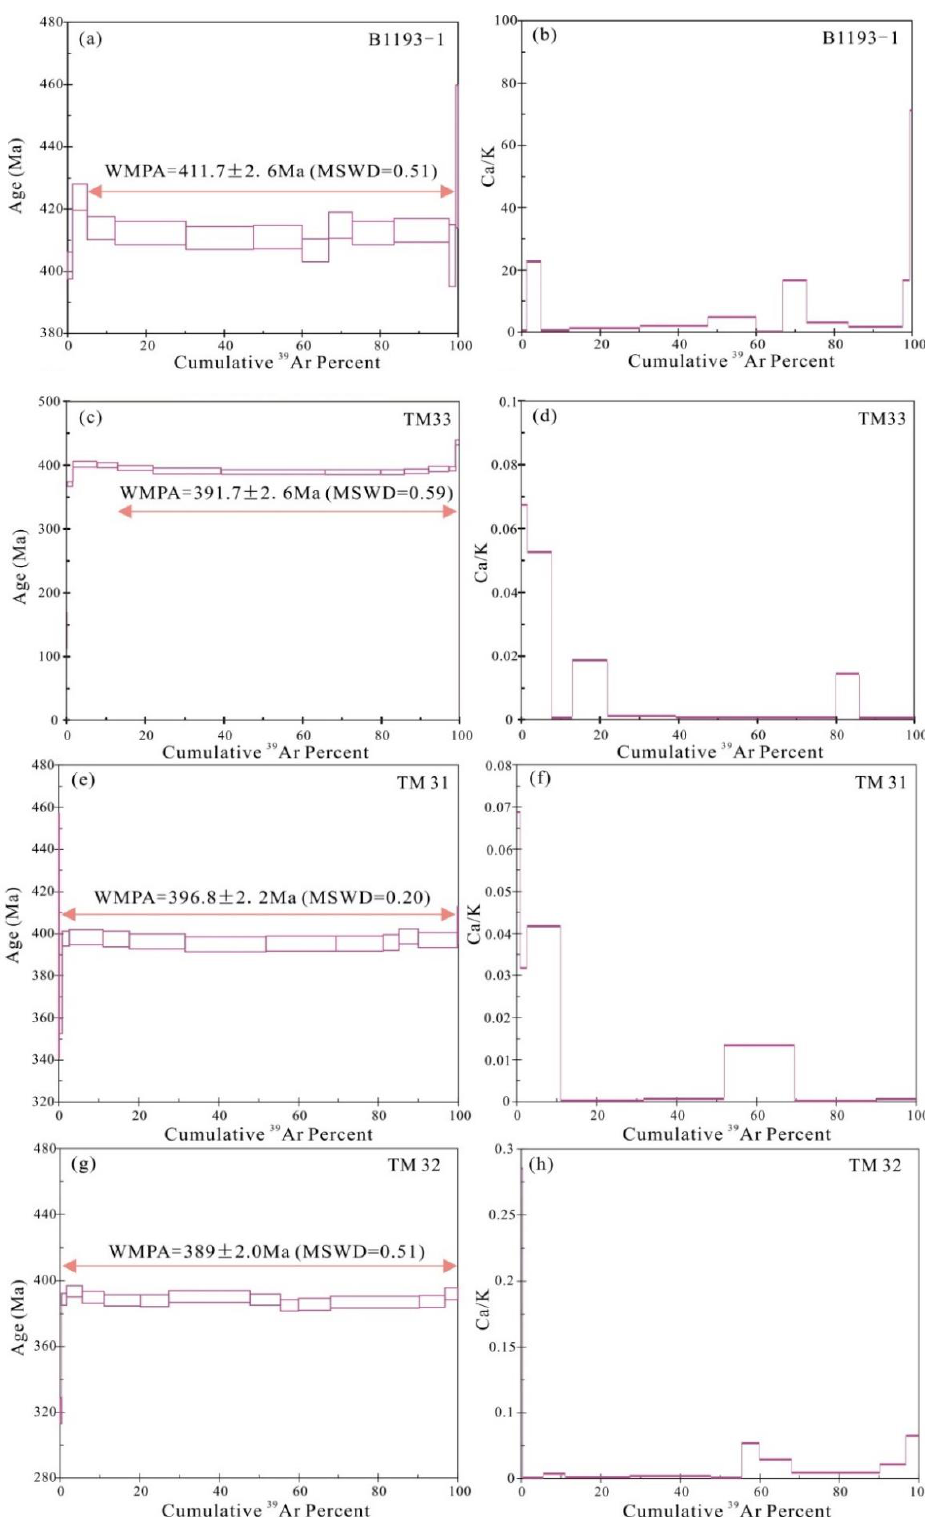
Figure 4. 40 Ar- 39 Ar weighted mean plateau and Ca/K ration spectra for muscovite from schist and monzogranite. ( a ) and ( b ) diagrams of plateau and Ca/K ration spectra for garnet muscovite schist (B1193-1); ( c ) and ( d ) diagrams of plateau and Ca/K ration spectra for muscovite quartz schist (TM33); ( e ) and ( f ) diagrams of plateau and Ca/K ration spectra for biotite monzogranite (TM31); ( g ) and ( h ) diagrams of plateau and Ca/K ration spectra for muscovite monzogranite (TM32). WMPA—weighted mean plateau age.